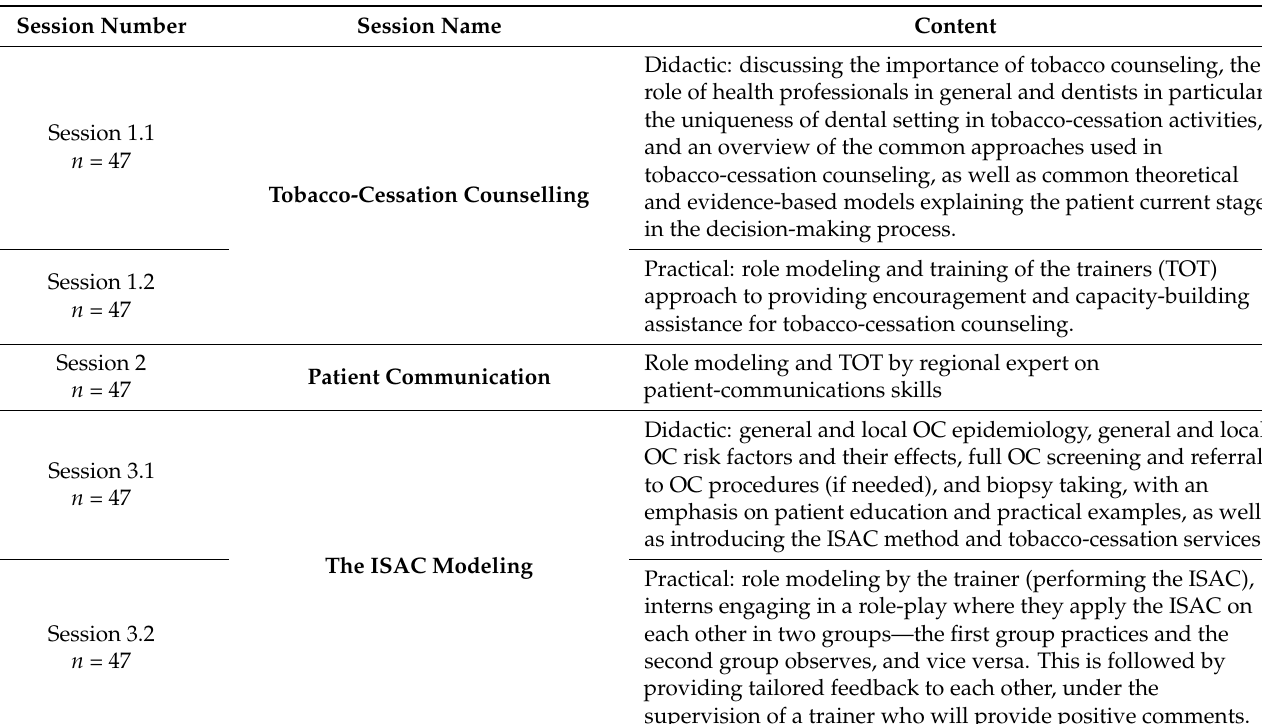
Table 1. Description of the ISAC